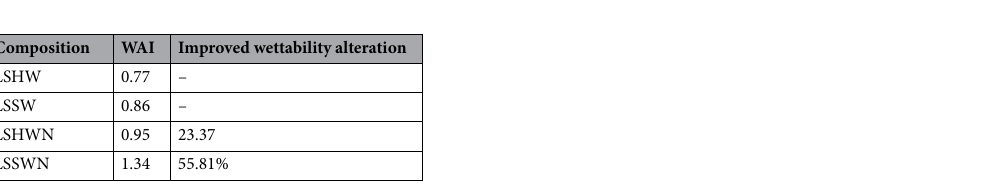
Figure 11. ( A ) Contact angle values of the oil-wetting thin section in the presence of LSHW, ( B ) LSHWN, ( C ) LSSW, ( D ) LSSWN.